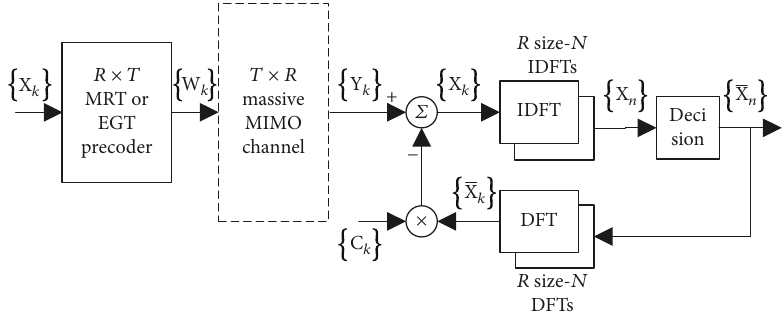
Figure 2: Block diagram of m-MIMO chain with receiver and interference cancellation associated with the